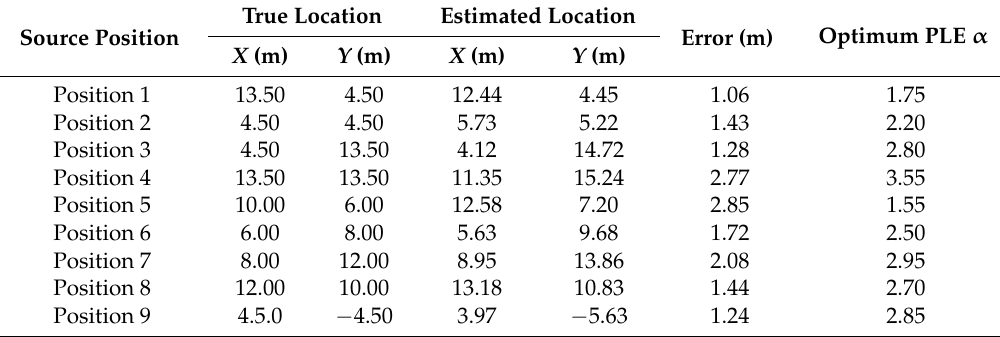
Table 3. PD source location estimation with eight sensors used, proposed method.